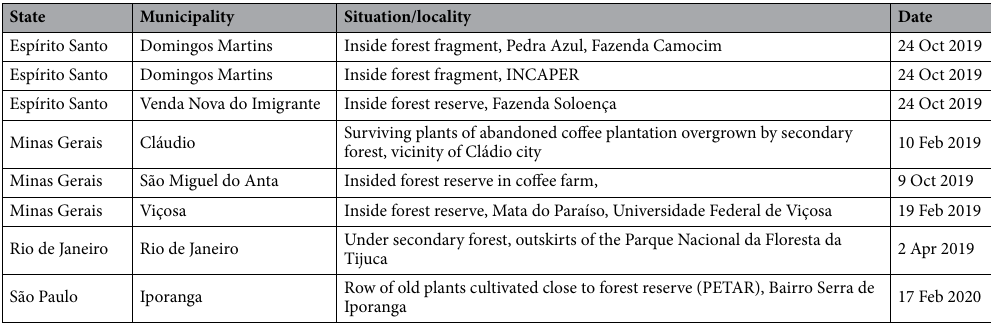
Table 3. Survey sites in Brazil of Coffea arabica , in semi-wild or forest situations, sampled for presence of Trichoderma endophytes.